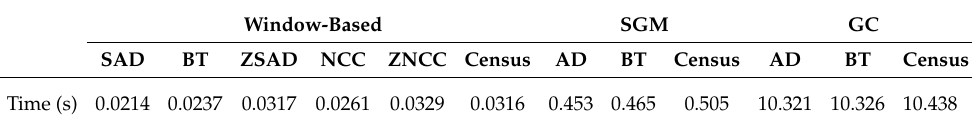
Table 2. Runtime of stereo matching techniques using GPU for synthetic Adirondack ( s